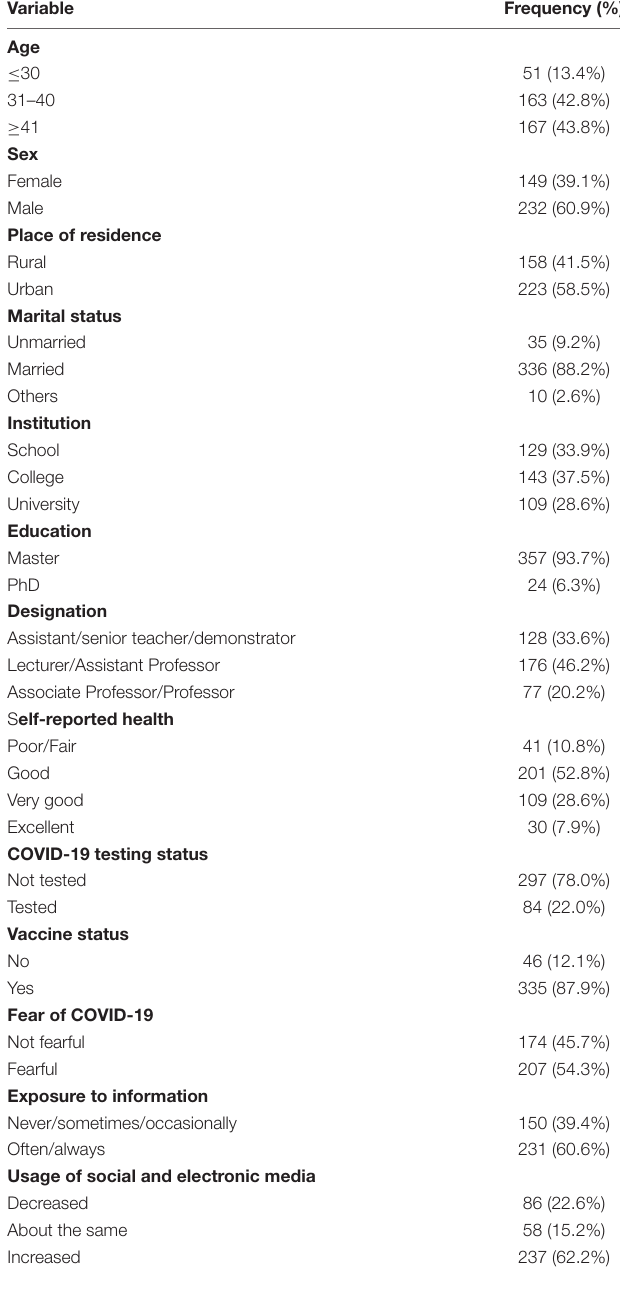
TABLE 1 | Descriptive information of the participants ( n =